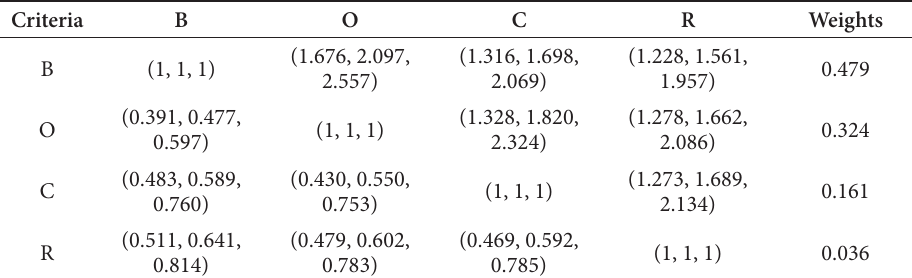
Table A6. Fuzzy pairwise comparison matrix of four decision criteria with respect to the goal